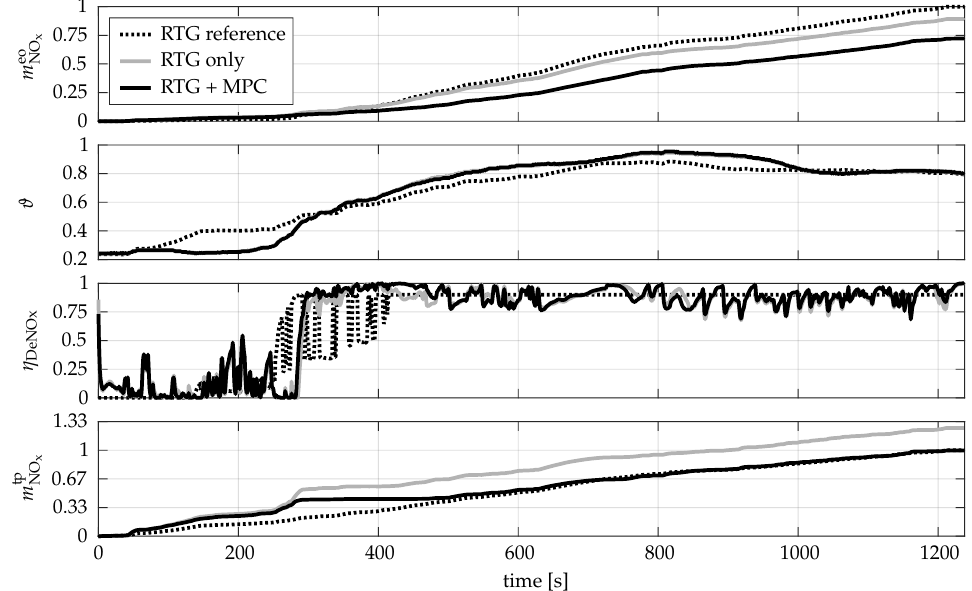
Figure 6. Resulting trajectories for the NRTC. The dotted gray trajectories were obtained by the RTG optimization. The solid gray trajectories show the measured operation with only the RTG, i.e., without feedback from the MPC. The solid black trajectories show the measured operation with the full predictive supervisory controller, i.e., with feedback from the MPC. All values were